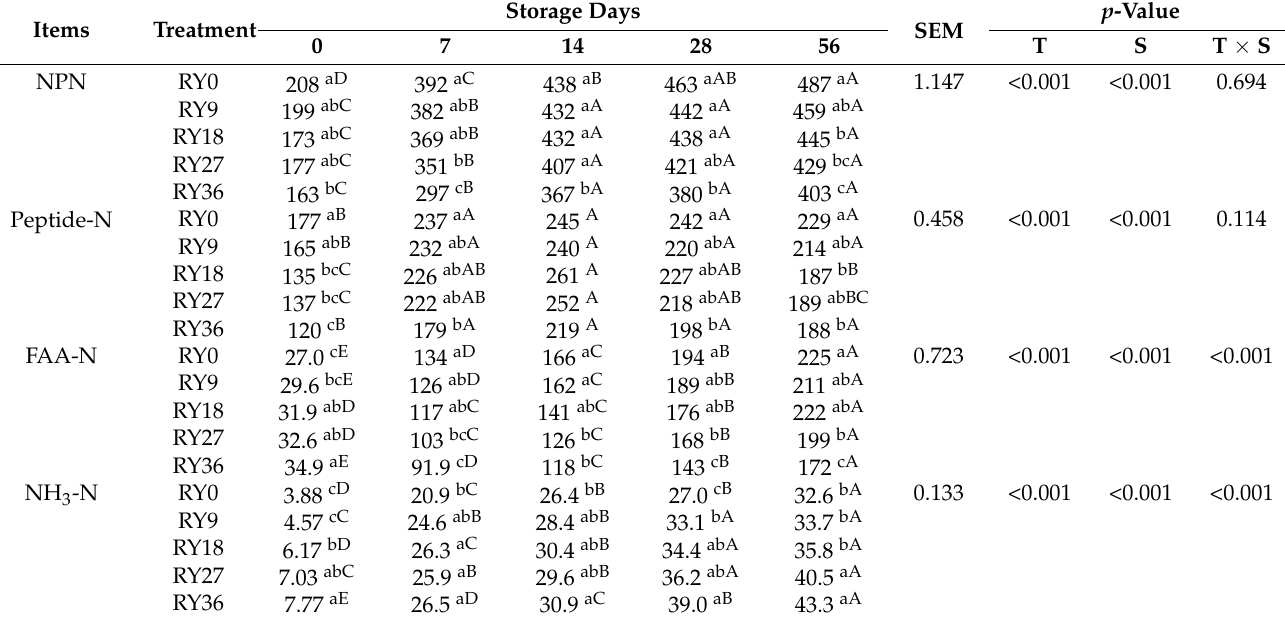
Table 6. Effect of paper mulberry replacement levels and storage days on nitrogen distribution of TMR silages (g/kg TN).